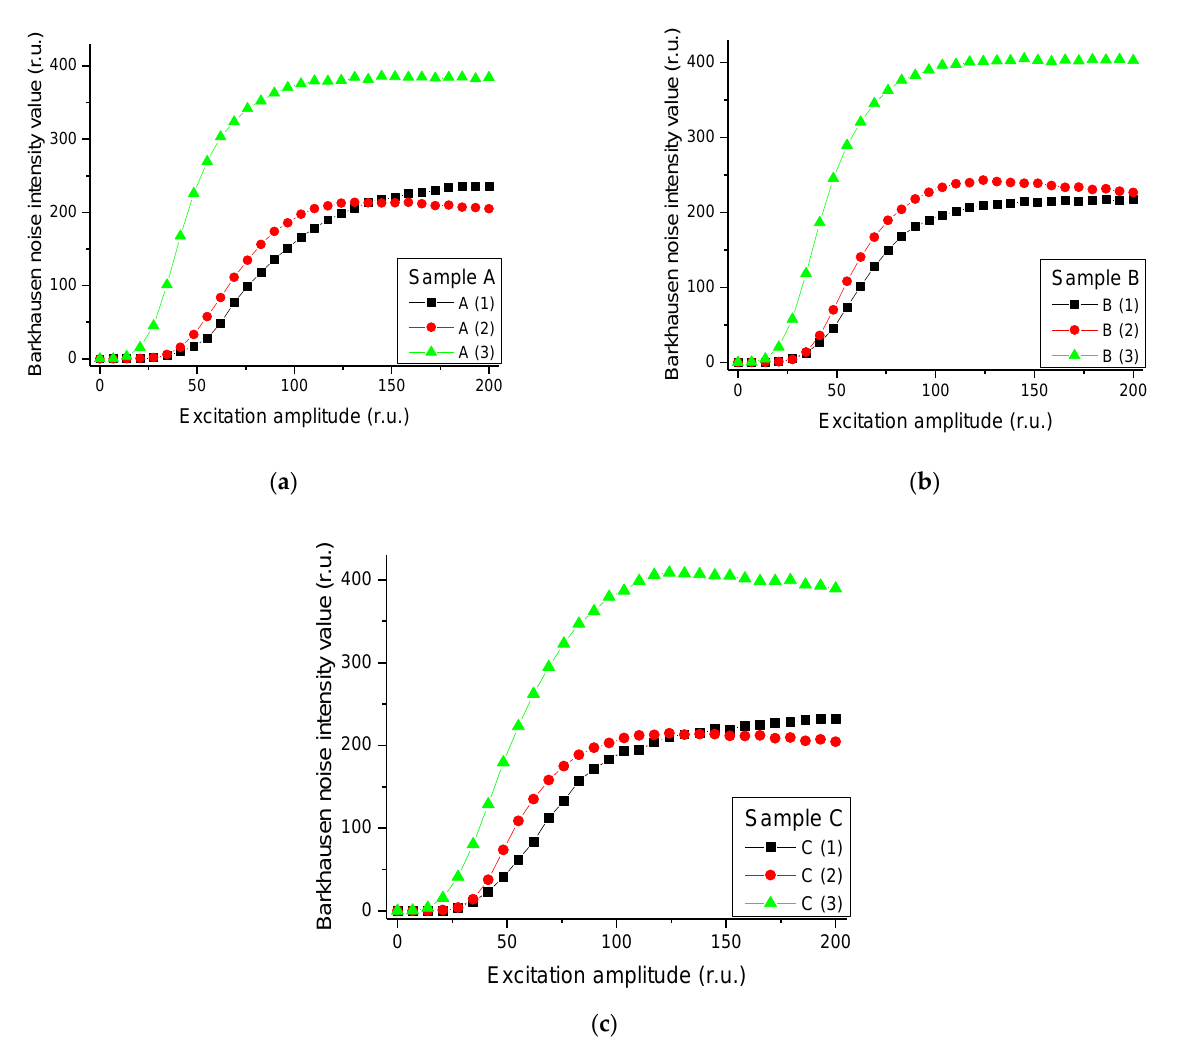
Figure 9. Measured magnetic Barkhausen noise intensity values with magnetization frequency of 120 Hz for Region (1) to (3) of each rail specimens: ( a ) Sample A, ( b ) Sample B, and ( c ) Sample C.